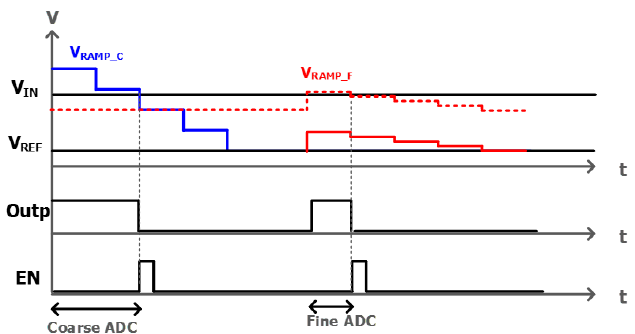
Figure 6. Circuit diagram of ( a ) conventional TSSS ADC with analog CDS block and ( b ) proposed TSSS ADC with DDA.